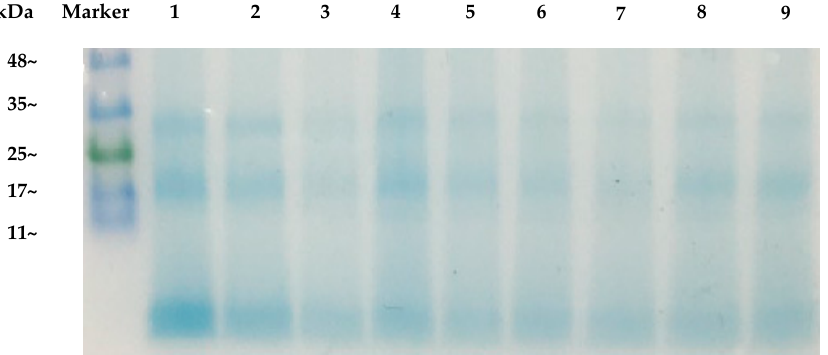
Data are expressed as mean ± SD (n = 3). a–f Means with different superscript letters in the same column were significantly different ( p < 0.05).